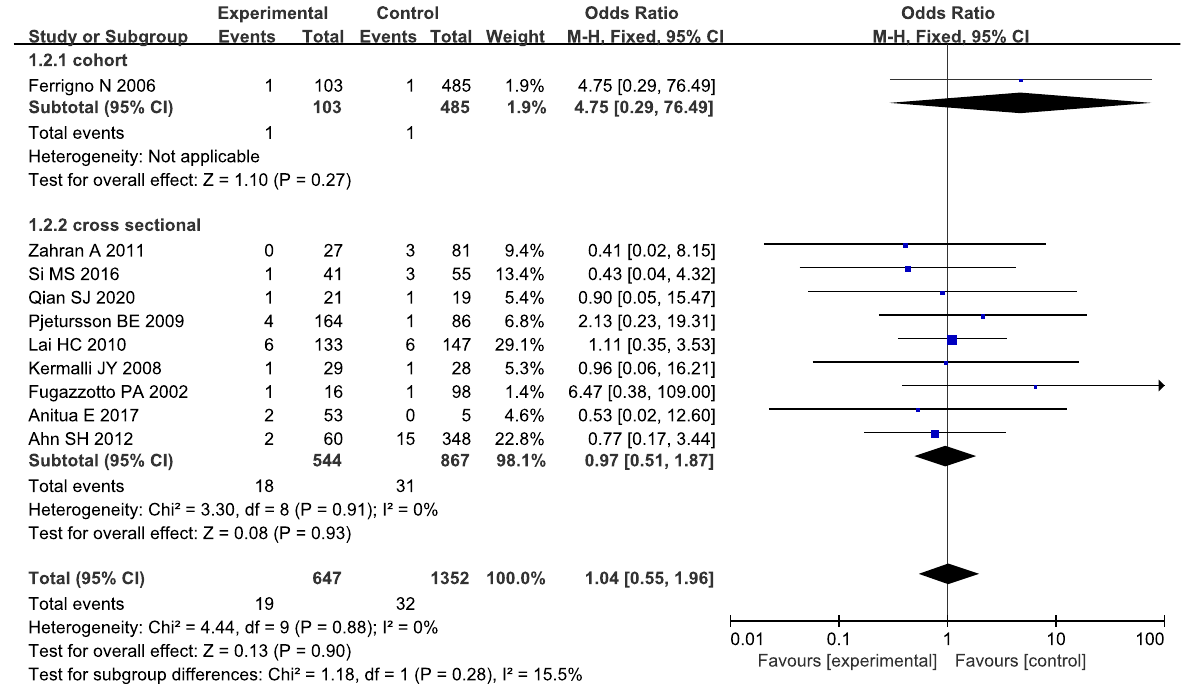
Fig. 3 Forest plot of the 1-year survival rate between short implants combined with TSFE (experimental group) and conventional implants combined with TSFE (control group)